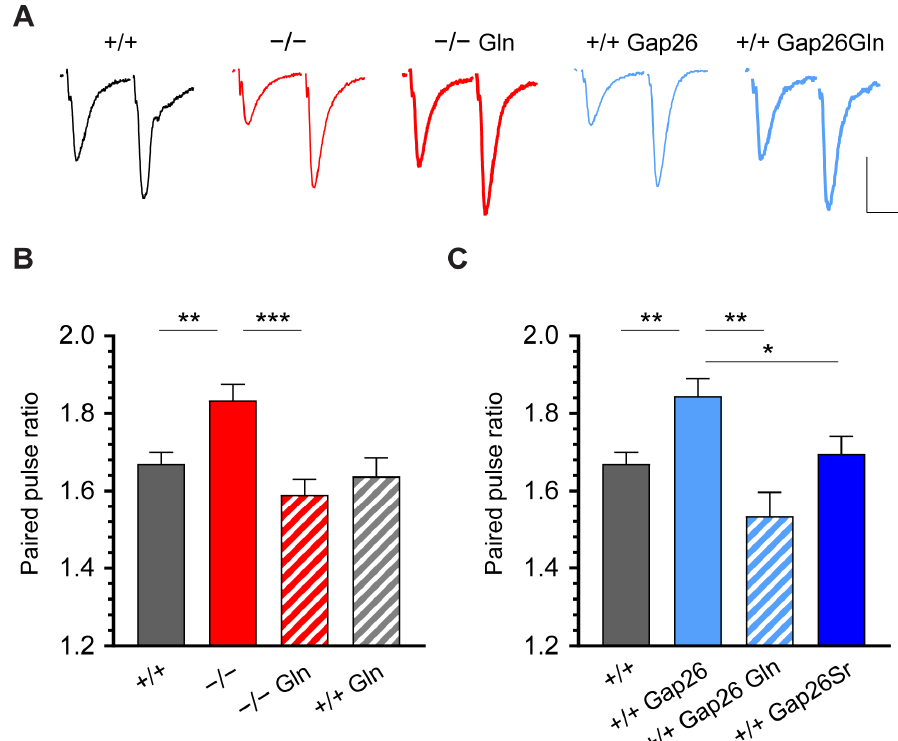
Figure 6. Astroglial Cx43 regulates the release probability in hippocampal neurons. ( A ) Representative recordings showing fEPSPs upon the Schaffer collateral paired-pulse stimulations (10–20 µ A, 0.1 ms, 40 ms apart). ( B ) The quantification of the fEPSP amplitude of the second stimulation relative to the first stimulation shows an increase in the paired-pulse ratio in the hippocampal slices from mice that are deficient in astroglial Cx43. These were then rescued by an exogenous application of glutamine (4 mM, − / − Gln, 1–4 h). Glutamine alone did not alter the paired pulse ratio (+/+ Gln). ( C ) This effect was mimicked by Gap26 in the +/+ slices (+/+ Gap26), but not by a scrambled version of Gap26 (+/+ Gap26Src) and rescued by exogenous glutamine (+/+ Gap26 Gln). Mean ± SEM; n = 19 (+/+), 16 ( − / − ), 9 ( − / − Gln), 8 (+/+ Gln), 17 (+/+ Gap26), 5 (+/+ Gap26 Gln), and 12 (+/+ Gap26Src) independent experiments; * p < 0.05, ** p < 0.01, *** p < 0.001; and scale bars: 0.2 mM, 20 ms in ( A ).